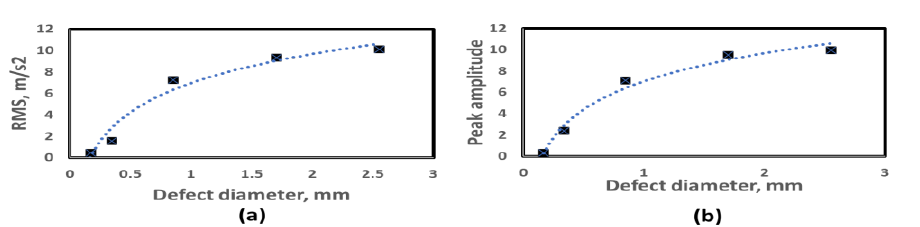
Figure 12. ( a ) The relationship between acceleration RMS and defect width, ( b ) The relationship between maximum peak amplitudes at second BPFO harmonics and defect width.